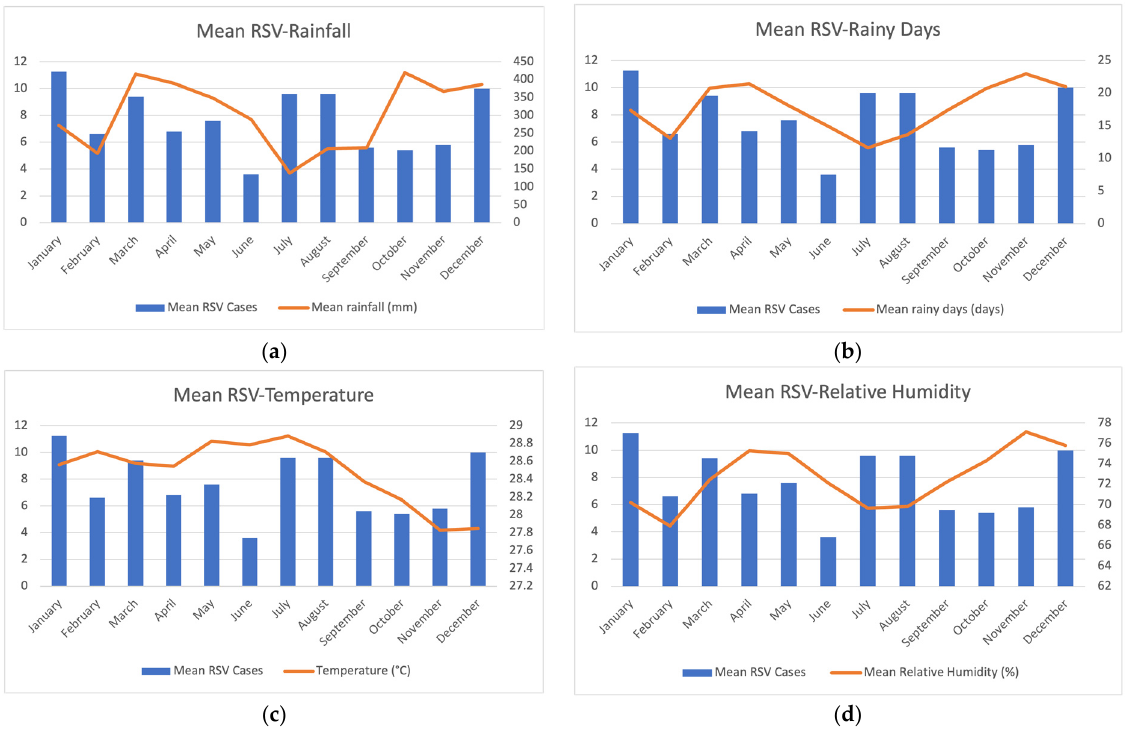
Figure 1. ( a – d ) Average monthly distribution of RSV-positive cases and various meteorological factors over the period of 5 years (2017–2021).